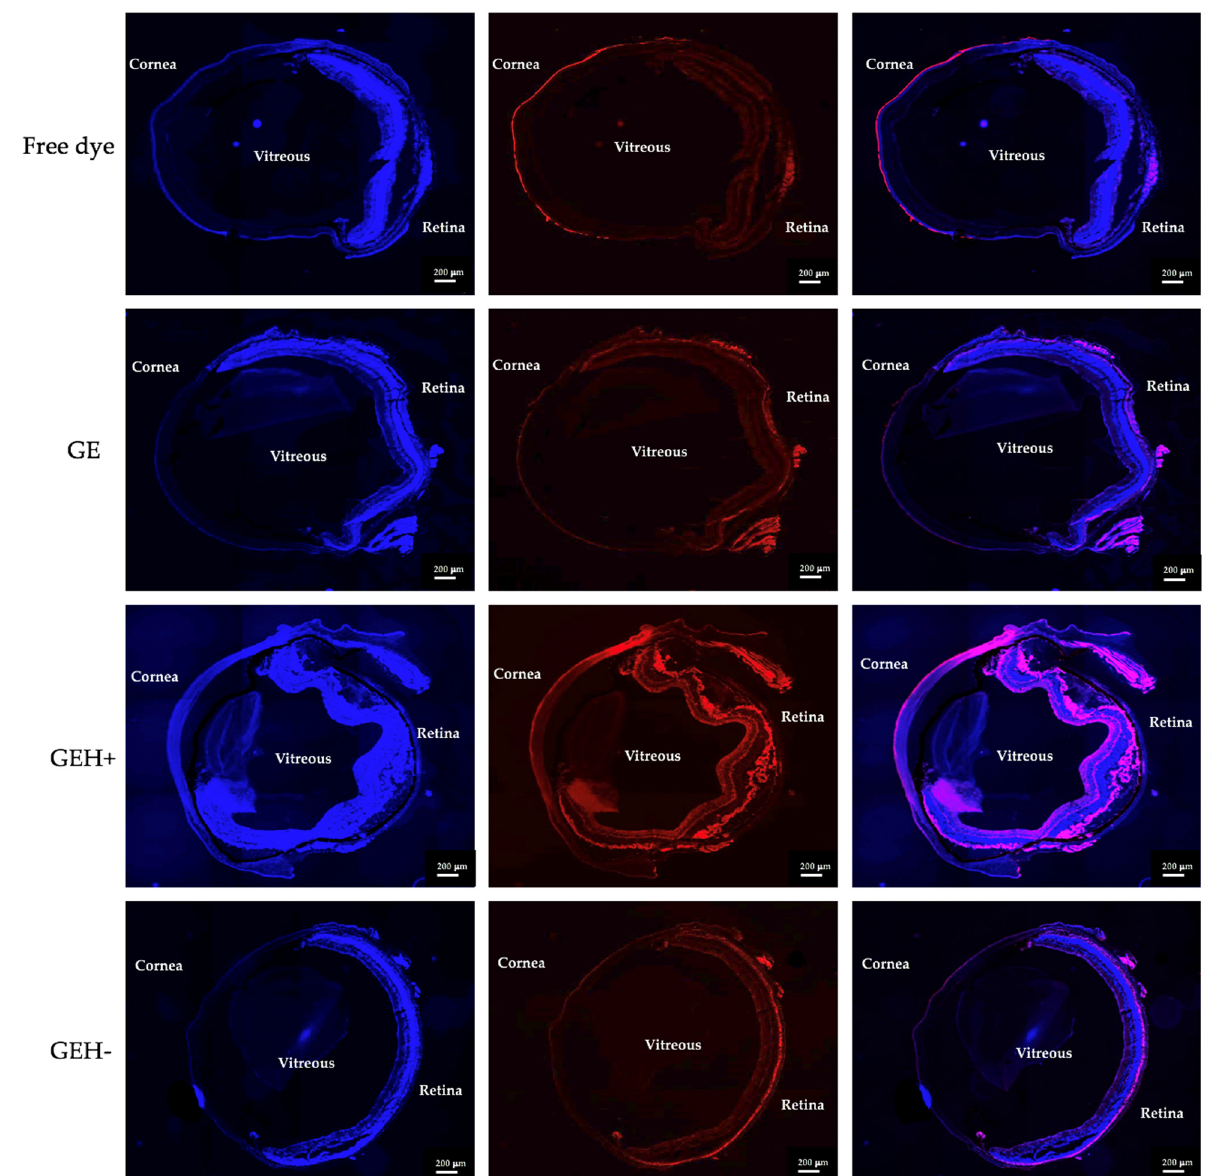
Figure 6. Fluorescent images of whole eyeball sections treated by different nanoparticles via topical administration (eye drops), after dosing for 30 min. (scale bar: 200 µ m) (Nuclear stained by DAPI in blue; dye (TAMRA)-conjugated NPs revealed in red; and the merged images).